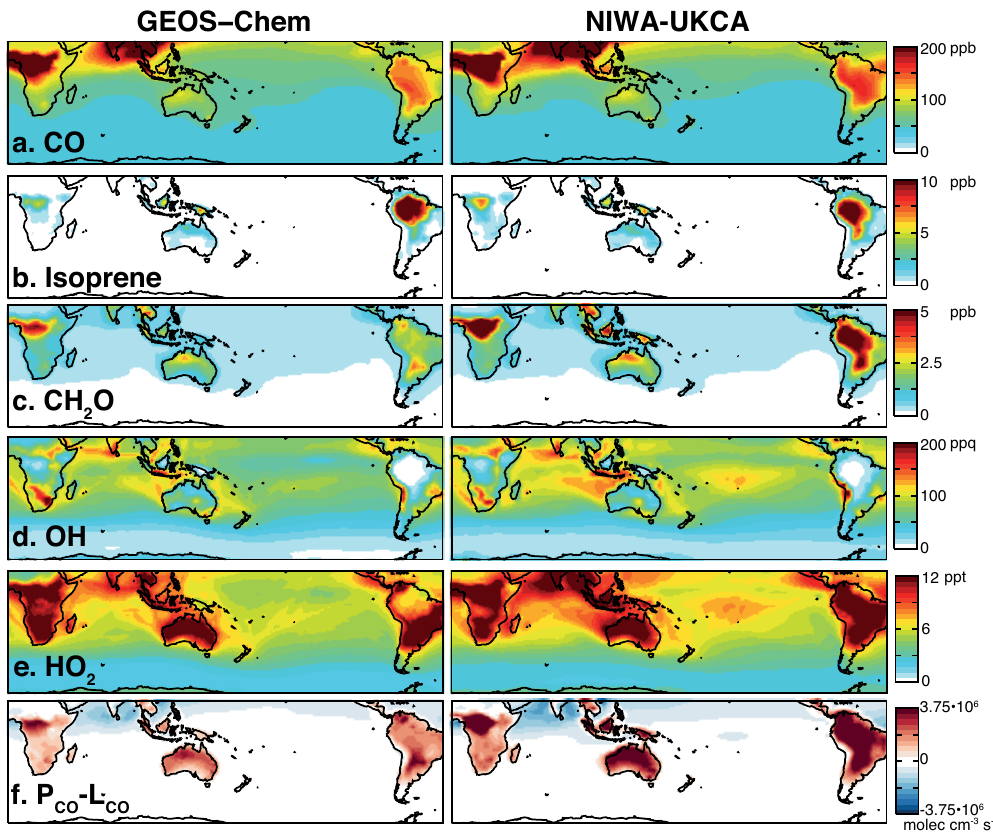
Figure 8. Five-year mean DJF mixing ratios in near-surface air ( < 1km) of (a) CO, (b) isoprene, (c) CH 2 O, (d) OH, and (e) HO 2 as simulated by GEOS-Chem (left) and NIWA-UKCA (right). (h) The bottom row shows the difference between rates of CO chemical production (P CO ) and CO chemical loss (L CO ) in molecules cm − 3 s − 1 for DJF 2004 only. Regions where production outweighs loss are shown in red and the inverse in